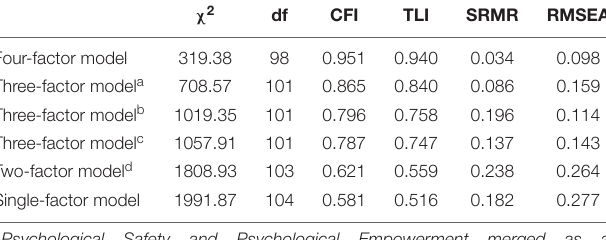
TABLE 4 | Results of confirmatory factor